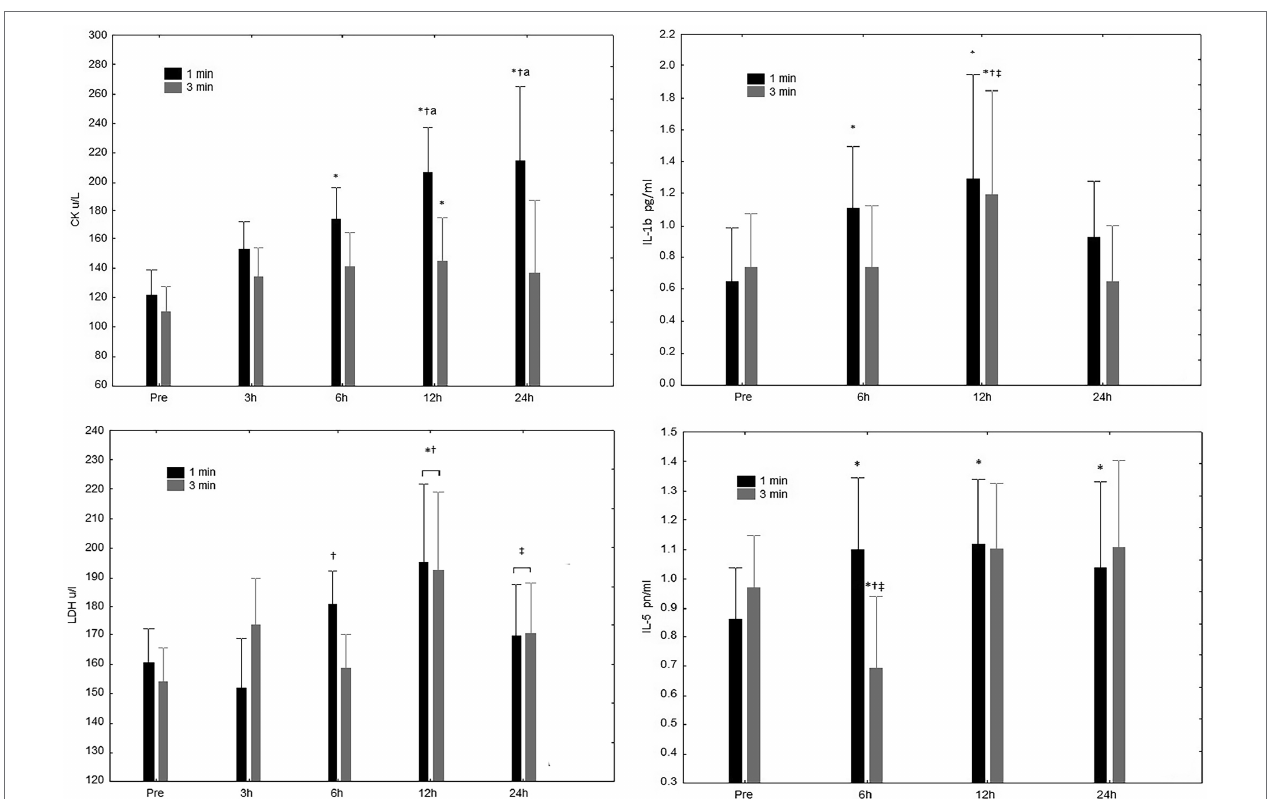
FIGURE 2 | CK/ul Creatine Kinase (CK) concentrations at pre-exercise (Pre), 3, 6, 12, and 24 h after completing five sets of bench press and leg press exercises with 1 or 3 min of rest between sets. LDH/ul L-Lactate Dehydrogenase (LDH) concentrations at pre-exercise (Pre), 3, 6, 12, and 24 h after completing five sets of bench press and leg press exercises with 1 or 3 min of rest between sets. *Significant difference to Pre ( p ≤ 0.05); † Significant difference to 3 h ( p ≤ 0.05); ‡ Significant difference to 12 h ( p ≤ 0.05). a Significant difference compared to 3-min rest condition ( p ≤ 0.05); IL-1b pg/ml Interleukin-1 β (IL-1 β ) concentrations at pre-exercise (Pre), 3, 6, 12, and 24 h after completing five sets bench press and leg press exercises with 1 or 3 min of rest between sets. IL-5 pn/ml Interleukin-5 (IL-5) concentrations at pre-exercise (Pre), 3, 6, 12, and 24 h after completing five sets of bench press and leg press exercises with 1 or 3 min of rest between